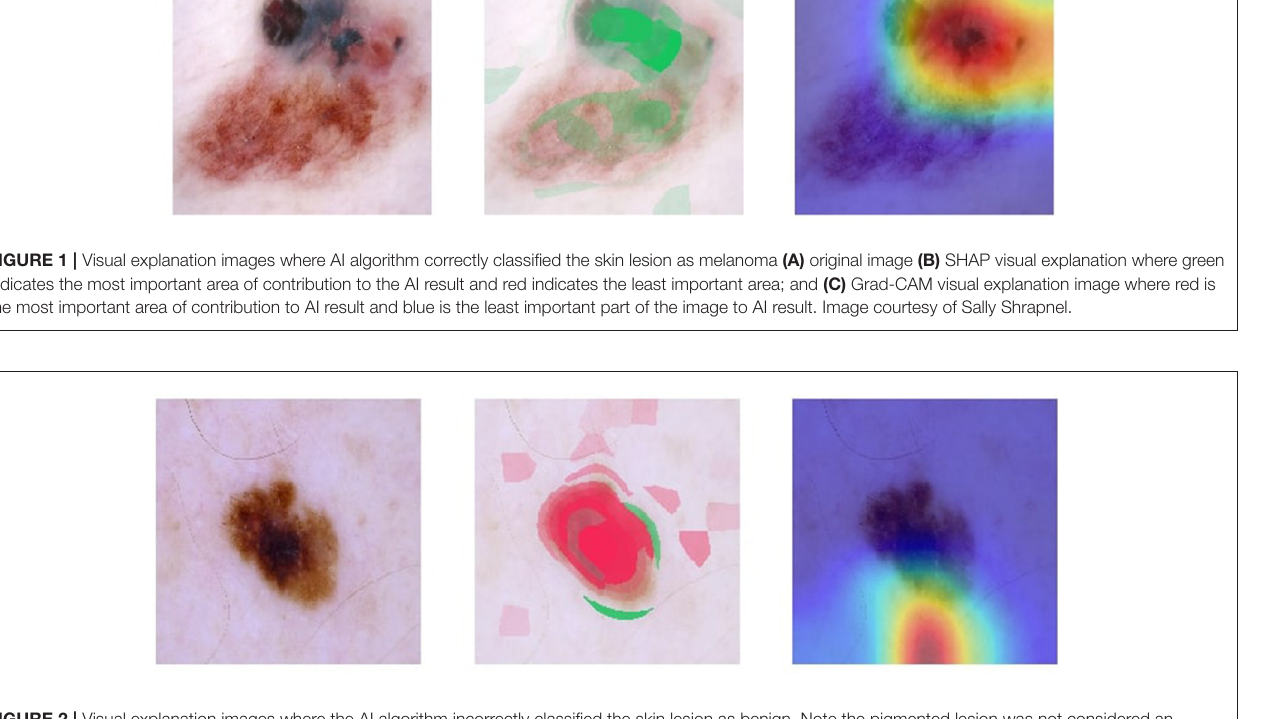
FIGURE 2 | Visual explanation images where the AI algorithm incorrectly classified the skin lesion as benign. Note the pigmented lesion was not considered an important feature by either SHAP or Grad-CAM. Image courtesy of Sally